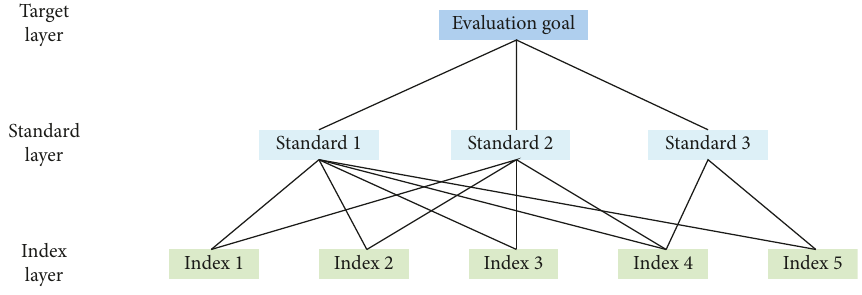
Figure 2: The AHP structure model diagram. Table 1: Interpretation table of the meaning of judgment